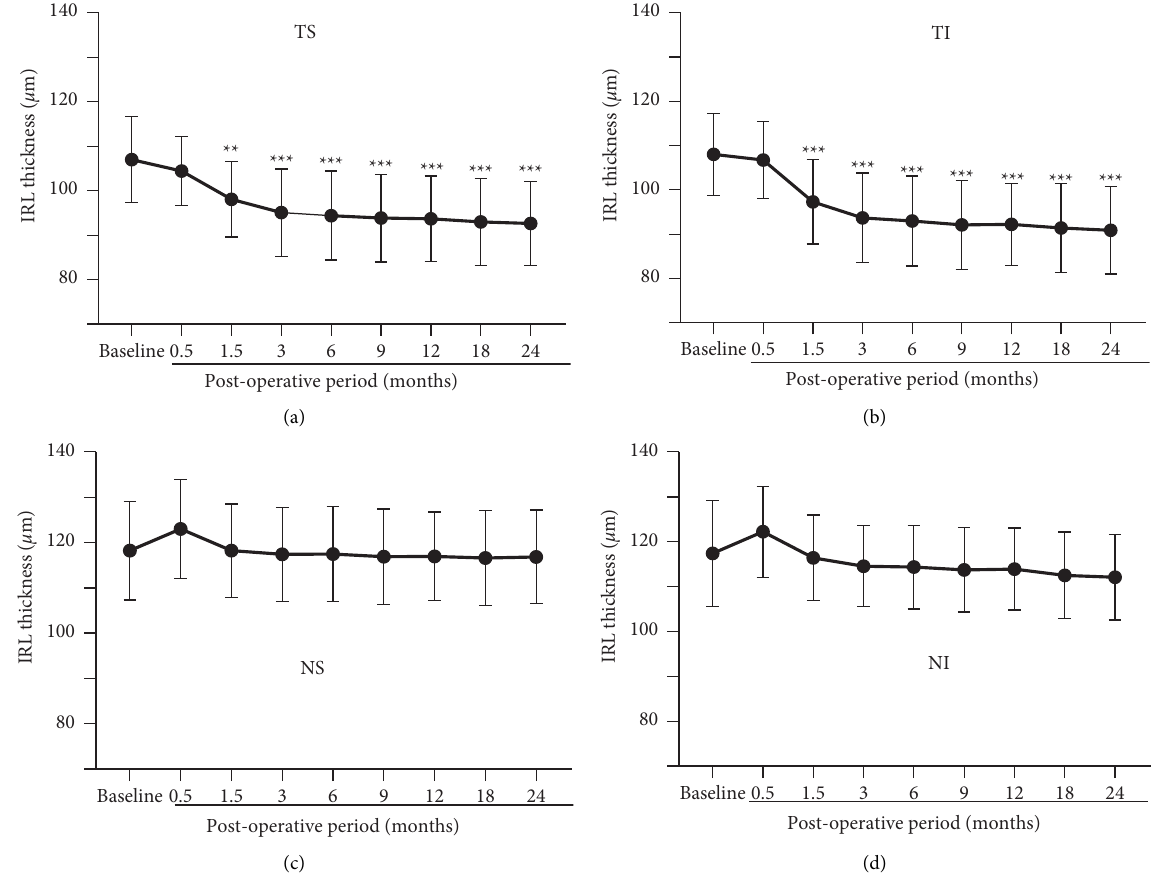
Figure 4: Mean thicknesses of the inner retinal layer (IRL) are plotted for the MH eyes treated with ILM peeling. In the temporal/superior (a) and temporal/inferior (b) quadrants, the IRL thickness significantly decreases with postoperative time up to 6 months with subsequent stability. Significant thinning of the IRL was found between the baseline (preoperative eyes) and postoperative eyes at 1.5 months and thereafter. MH, macular hole; ILM, internal limiting membrane; TS, temporal/superior; TI, temporal/inferior; NS, nasal/superior; NI, nasal/ inferior. Asterisks represent significant differences between the control and operated eyes. ∗∗ P < 0 . 005; ∗∗∗ P < 0 . 0001.